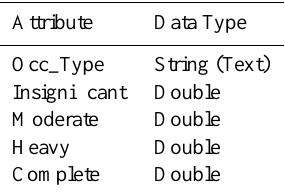
Table 7. Required attributes in building damage data.